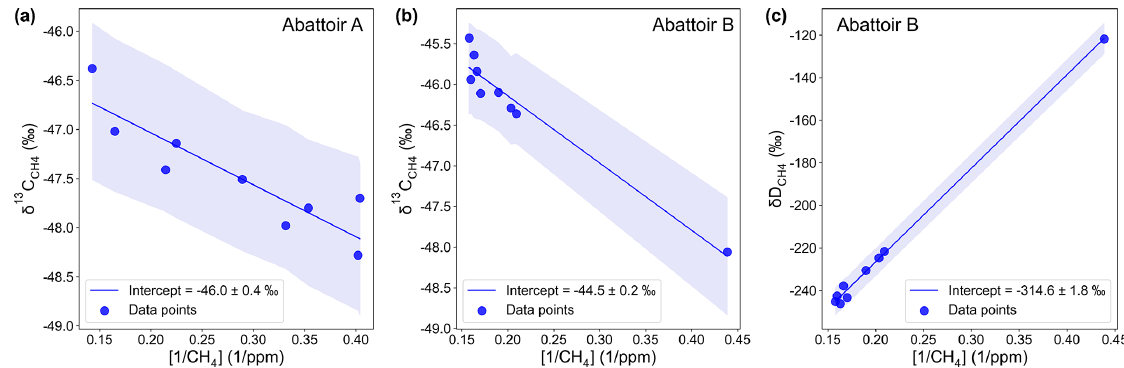
Figure A6. Keeling plots of all data from export abattoirs analysed using Bayesian linear regression. Panel (a) ( δ 13 C) shows the result for Abattoir A and panels (b) ( δ 13 C) and (c) ( δ D) show the results for Abattoir B.